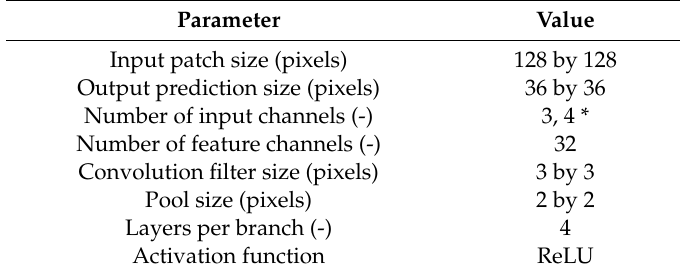
Table 3. U-NET architecture used in this study for U-NET SPECS and U-NET PCA.